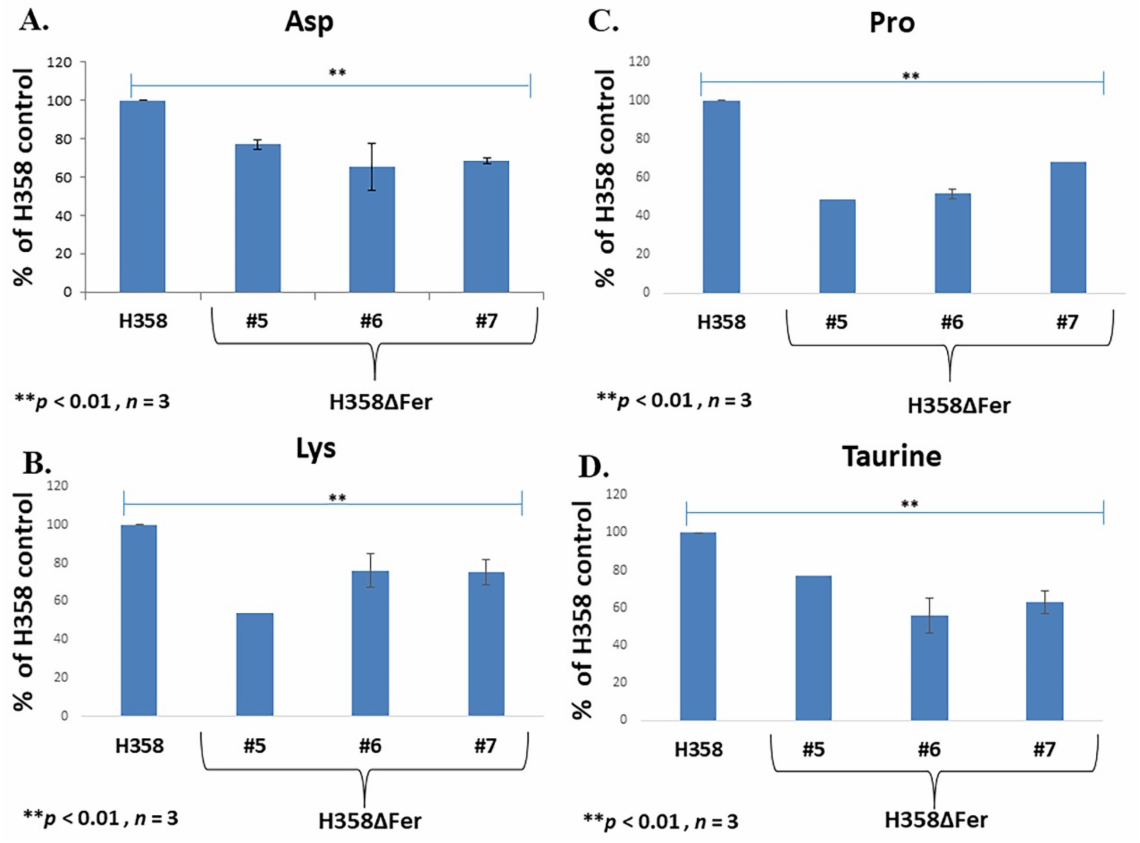
Figure 4. Fer sustains mitochondrial homeostasis in H358 cells. ( A ) Reverse HPLC analysis of the TCA metabolite- aspartate, levels, ( B ) LC-MS analysis of Lys, ( C ) Pro and ( D ) methionine-derived taurine amino acids in H358 cells and H358 ∆ Fer clones. Cells were supplemented with glutamine and grown in the absence of glucose. Histograms represent means +/ − SE ( n = 3). ** p -value < 0.01